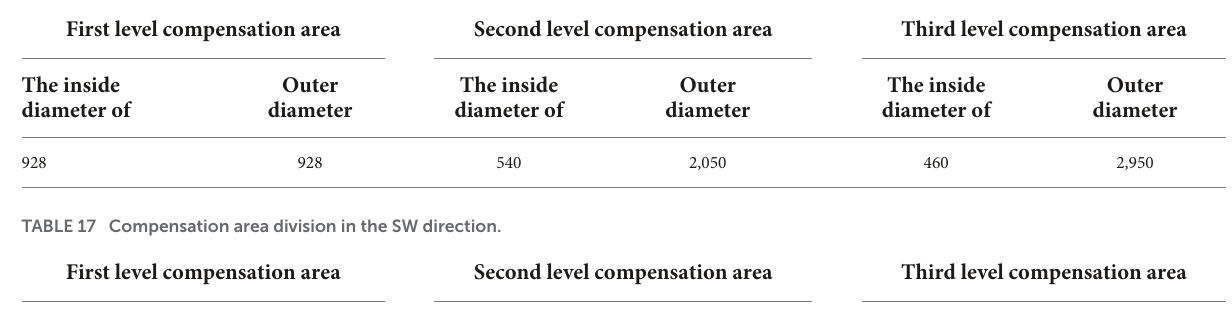
TABLE 16 Division of compensation regions in the S direction.